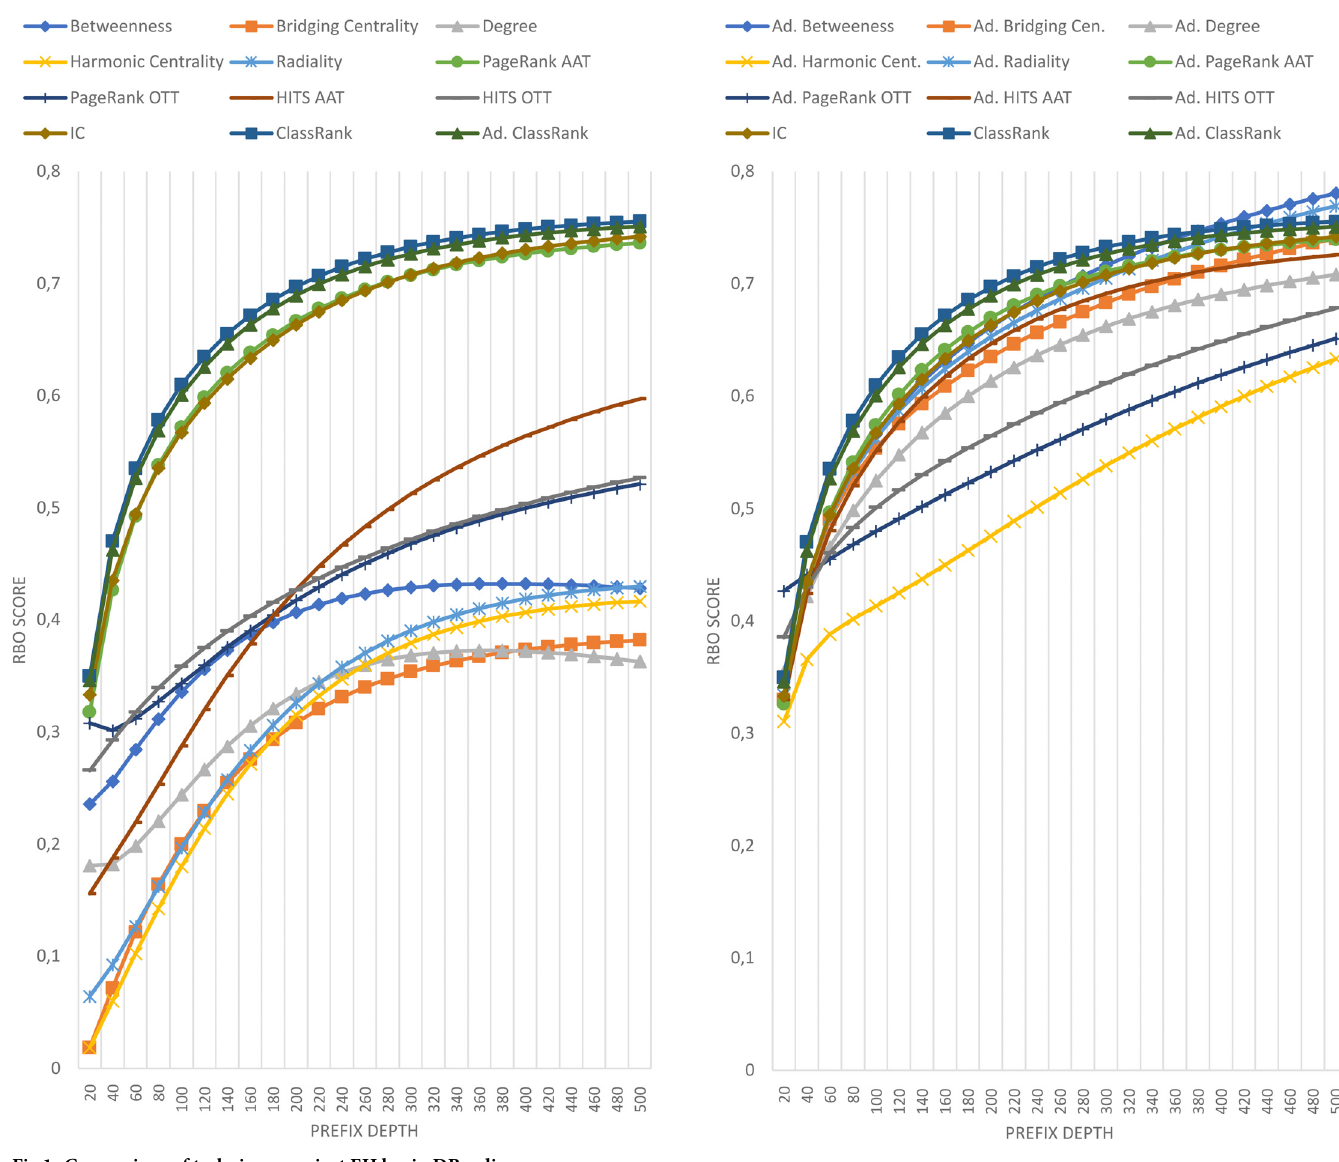
Fig 1. Comparison of techniques against EH log in